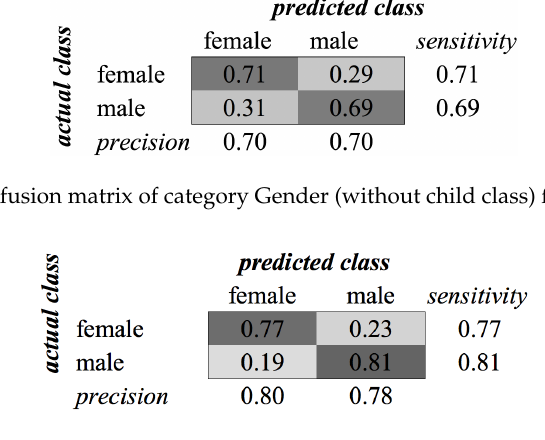
Figure A8. KHMM confusion matrix of category Gender (without child class) for MFCC feature type.